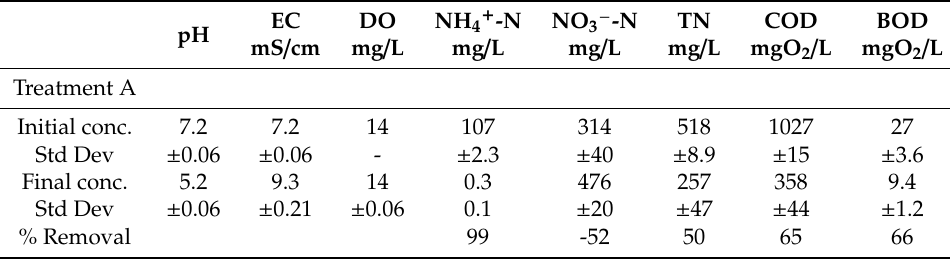
Table A1. Percentage removal based on the initial and final mean values of physicochemical parameters, organic, and nitrogen compounds concentrations. Final concentrations represent the recorded values at the end of the second stage of the experiment (COD depletion